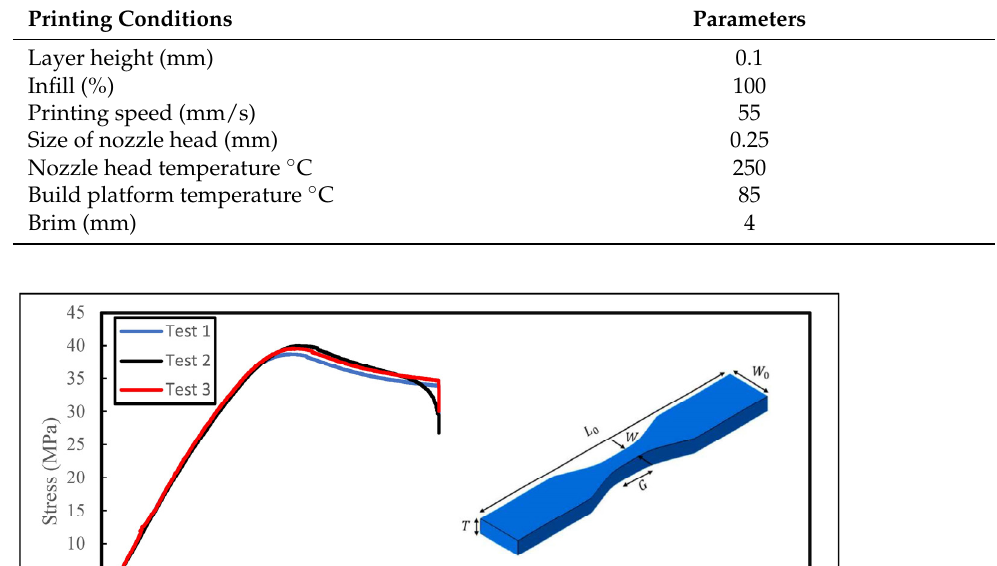
Table 4. Input material parameters of acrylonitrile butadiene styrene (ABS).